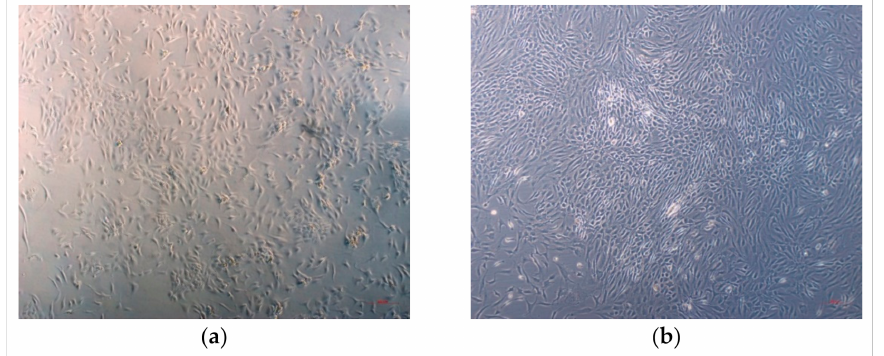
Figure 1. The primary culture of cartilaginous endplate cells. ( a ) Eight days after the isolation, low-density cultures with individual round to polygonal-shaped cells were evident. ( b ) Two weeks after the isolation, the cells completely cover the flask surface, forming seemingly strong intercellular connections. Images were taken at 50 × magnification on Zeiss Axiovert 40 inverted microscope. Scale bar = 200 µ